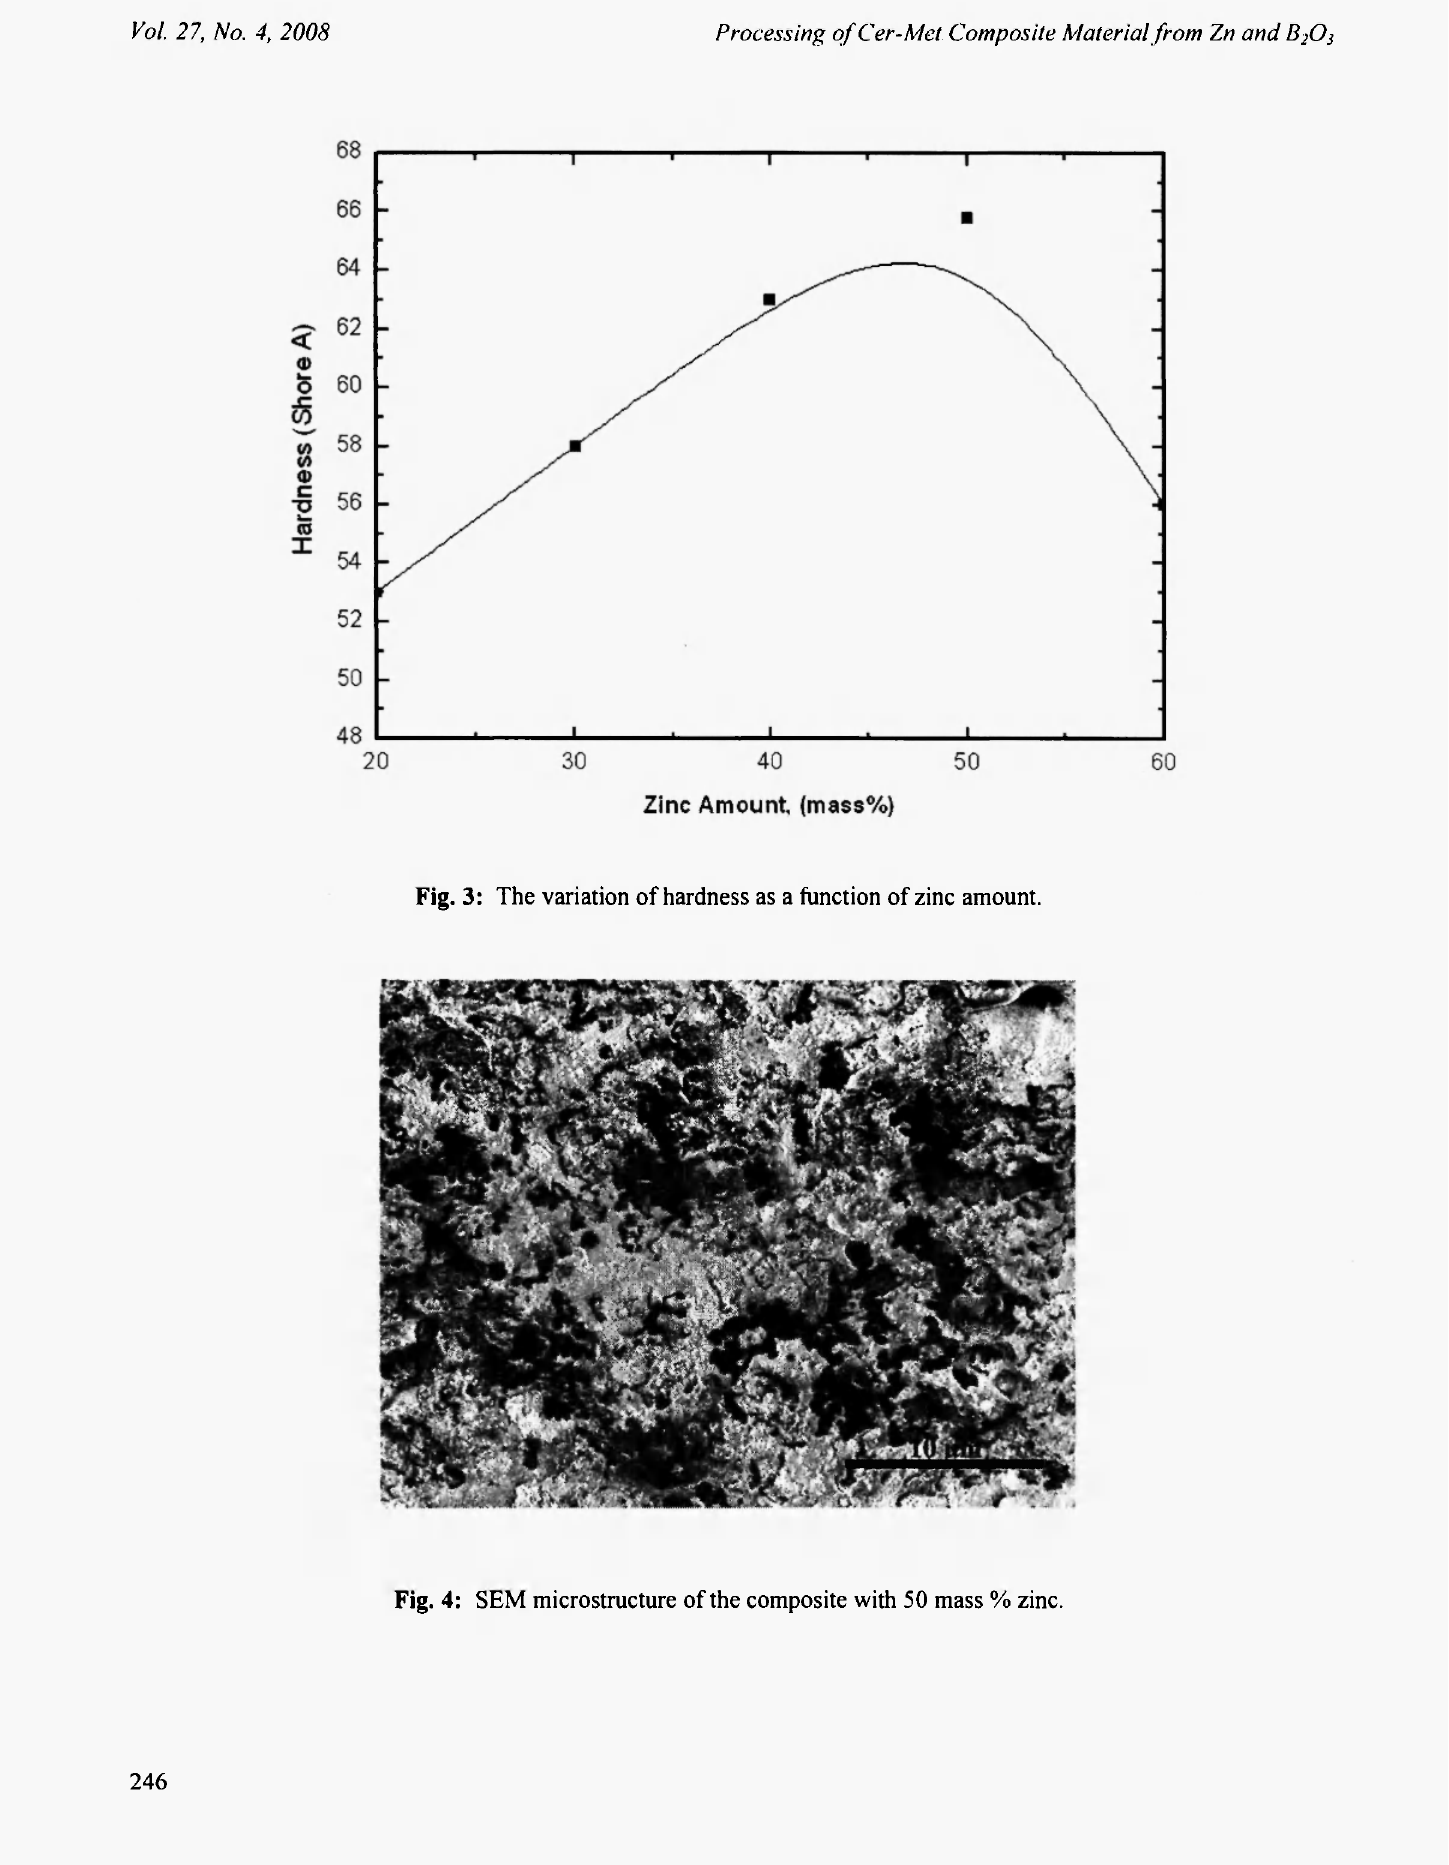
Fig. 3: The variation of hardness as a function of zinc amount.